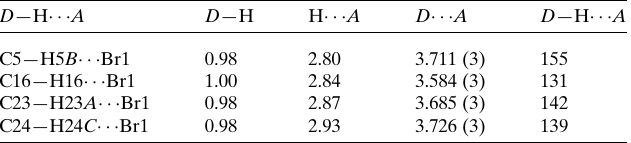
Table 2 Hydrogen-bond geometry (A˚ , (cid:3) ) for II .